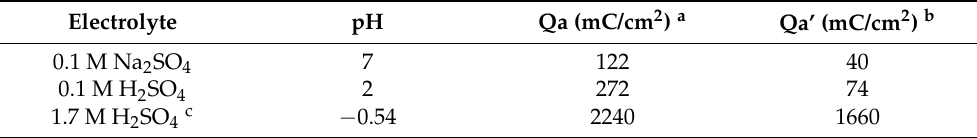
Figure 3. Typical CPE-ZnS voltamperograms (70:30 wt.%) obtained at a scan speed of 100 mVs − 1 , without electrolyte agitation for EBHSS. ( a ) 0.1 M Na 2 SO 4 , pH = 7; ( b ) 0.1 M H 2 SO 4 , pH = 2; ( c ) 1.7 M H 2 SO 4 . The red line indicates negative direction; black line, positive direction. Full line squares show the detailed redox processes of the samples indicated in dashed squares. Table 2. Charge densities associated to the anodic oxidation peaks of the oxidative dissolution of